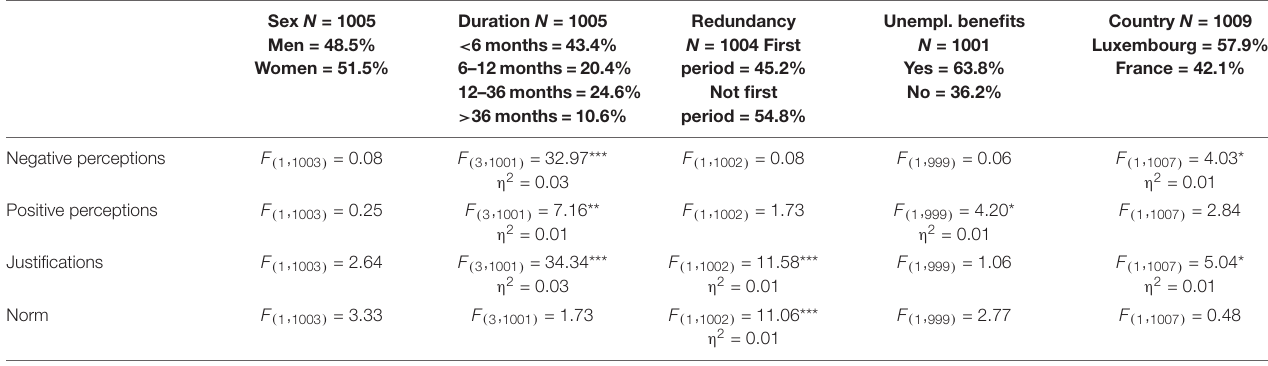
TABLE 3 | ANOVAs on normalization dimensions and demographic